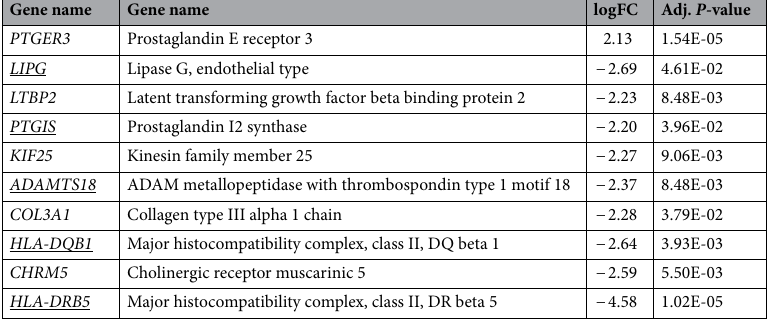
Table 4. DEG in ALL between HC and AD. Underlined genes were already reported in